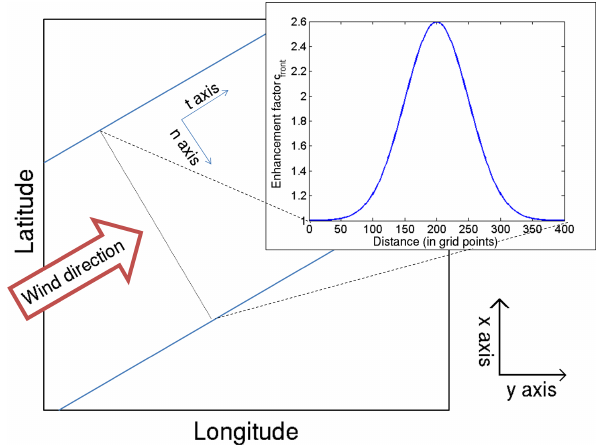
Figure 4. Schematic of a Gaussian-shaped distribution of the frontal enhancement factor with a maximum of c front = 2 . 6 and σ n = 50 (upper right corner), and its location in the model domain for a southwesterly wind direction (arrow). The blue lines indicate the boundaries of the frontal zone.